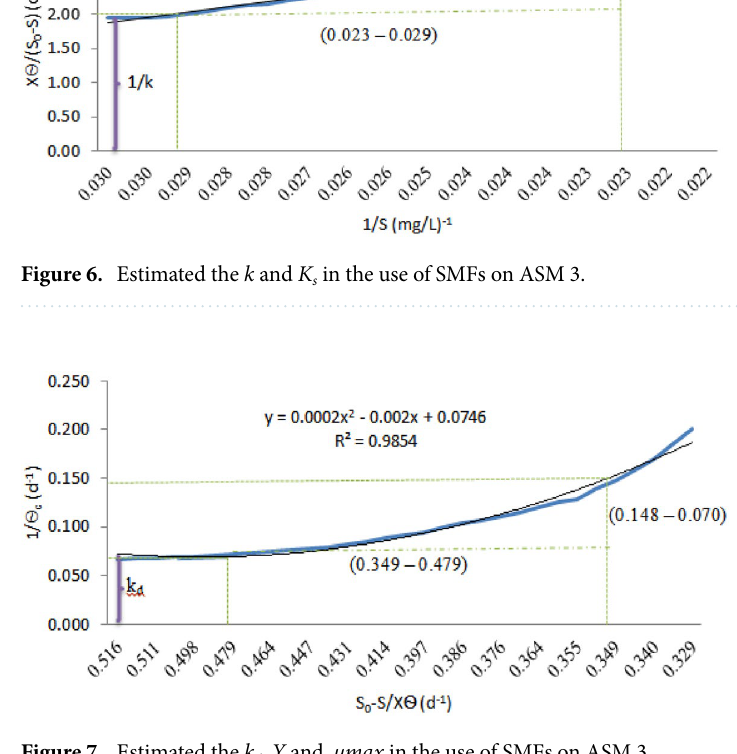
Figure 7. Estimated the k d , Y and, µmax in the use of SMFs on ASM 3.